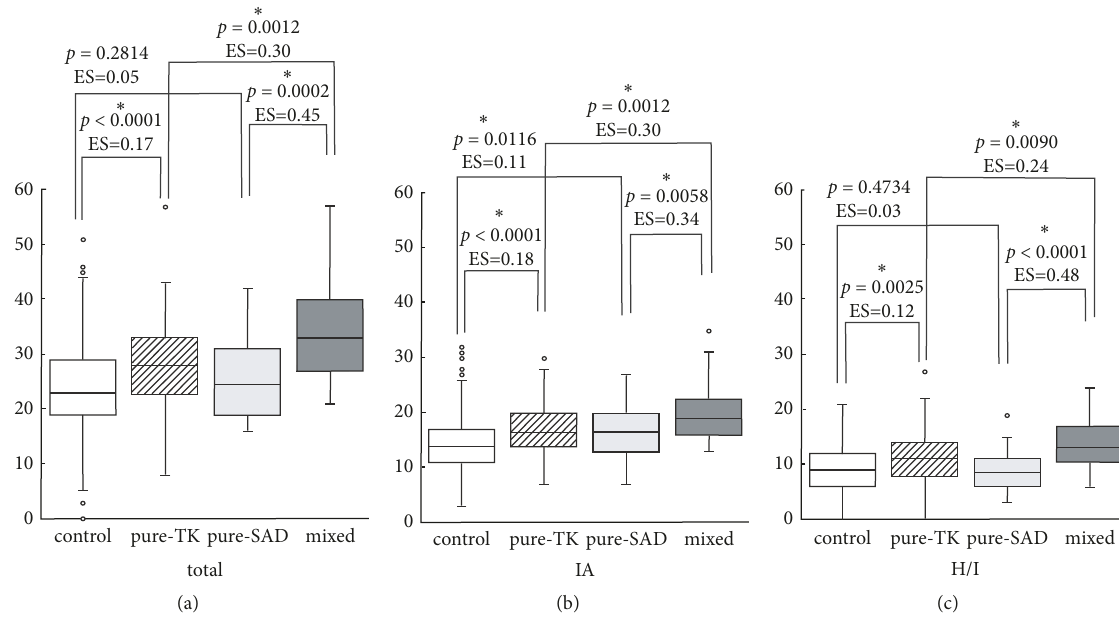
Figure 1: Box-and-whisker plots of adult ASRS scores. (a) Comparison of the total score on the ASRS. (b) Comparison of scores for IA- (inattention-) related items of the ASRS. (c) Comparison of scores for H/I- (hyperactivity/impulsivity-) related items of the ASRS. White boxes: healthy control group [LSAS-J: cut-off value (COV) < 60/TK: COV < 122]. Boxes with oblique lines: pure-TK group (LSAS-J: COV < 60/TK: COV ≥ 122). Light gray boxes: pure-SAD group (LSAS-J: COV ≥ 60/TK: COV < 122). Dark gray boxes: mixed group (LSAS-J: COV ≥ 60/TK: COV ≥ 122). Differences among all groups were statistically significant (p < 0.001, Kruskal-Wallis test). Comparison between two groups was performed using the Mann-Whitney U test with Bonferroni correction ( ∗ p < 0.0125). ES: effect size; SAD: social anxiety disorder; ASRS: ADHD Self-Report Scale; LSAS-J: the Japanese version of the Liebowitz Social Anxiety Scale; TK: Taijin-Kyofu-sho .